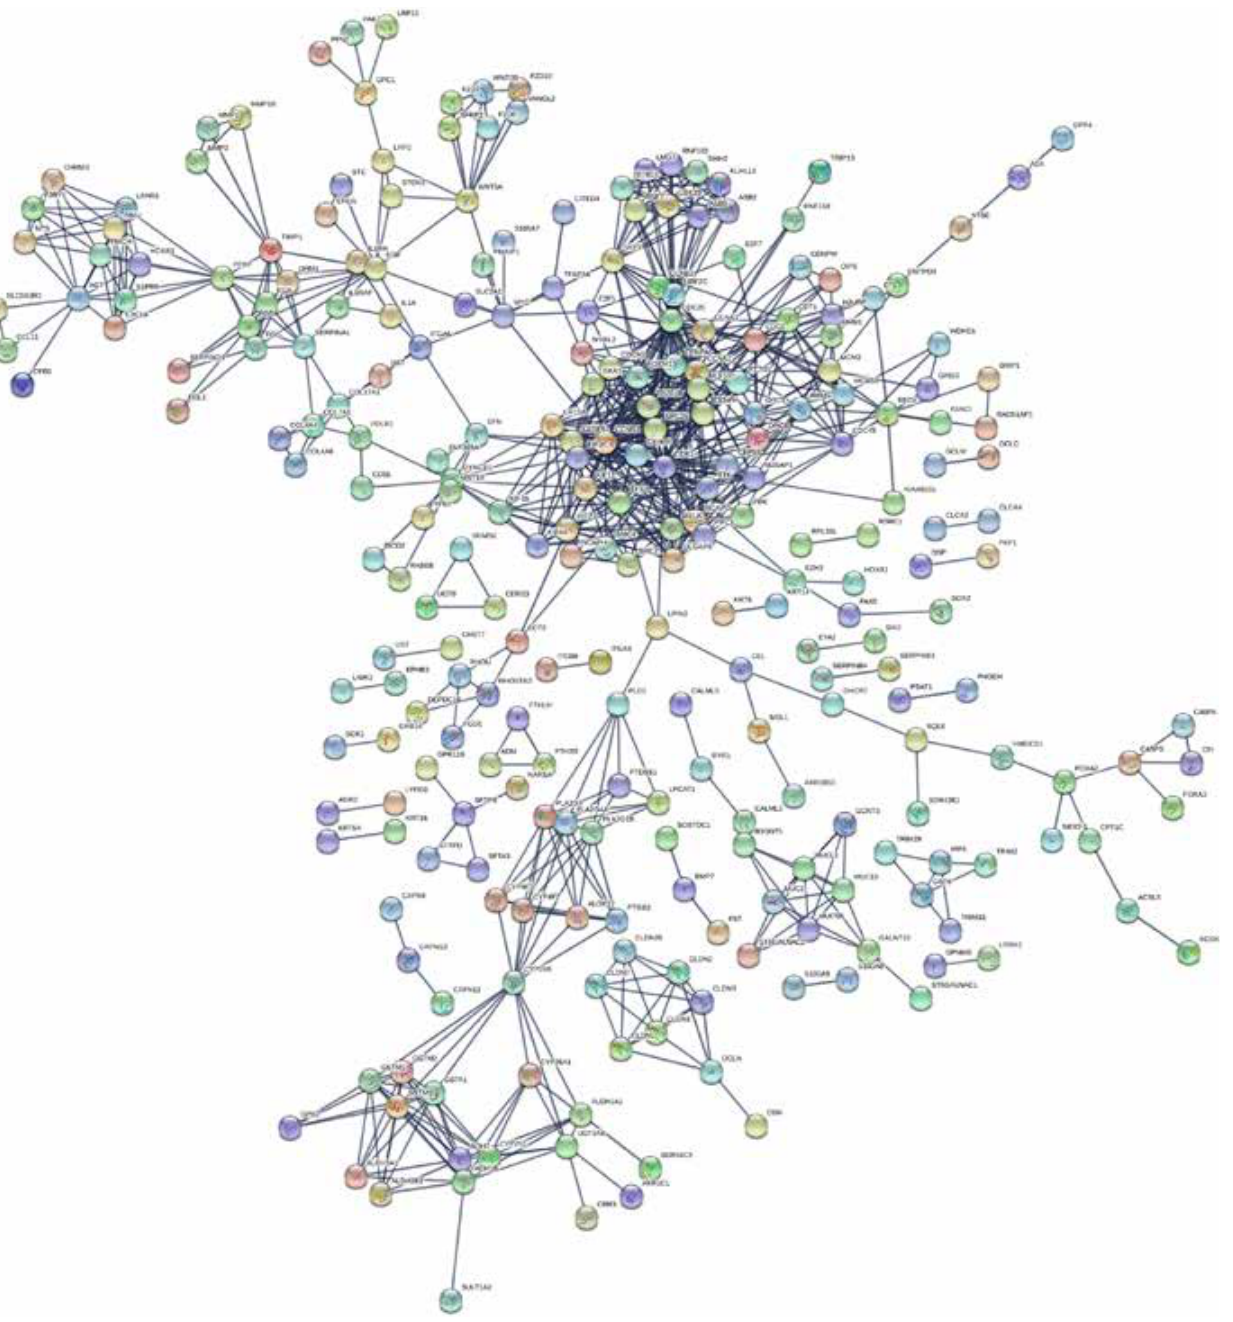
Figure 3 Protein-protein interaction (PPI) network of the 784 differentially expressed genes